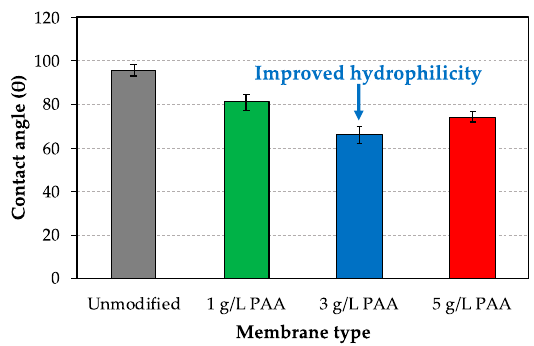
Figure 3. Hydrophilicity analysis: contact angle data.